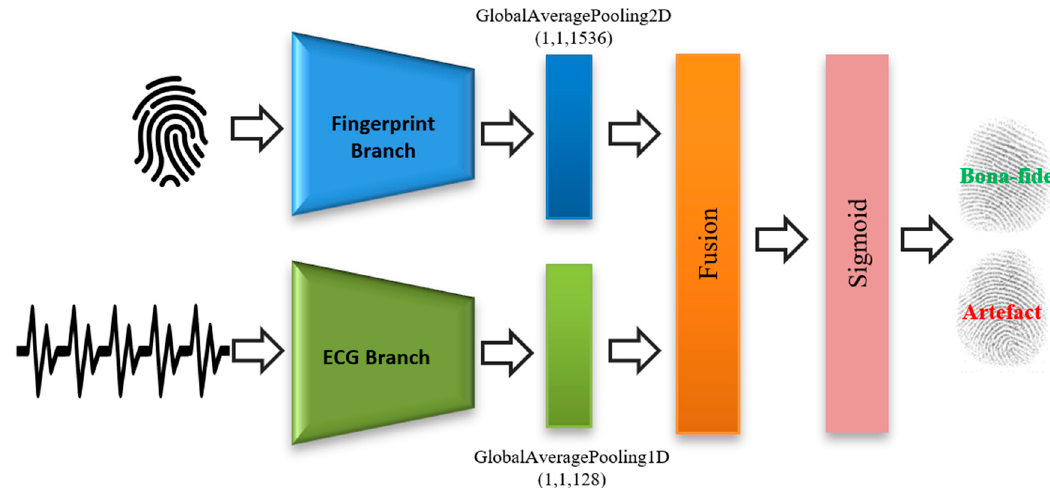
Figure 2. Overall architecture of the proposed end-to-end convolutional neural network-based (CNN) fusion architecture. ECG, electrocardiogram.